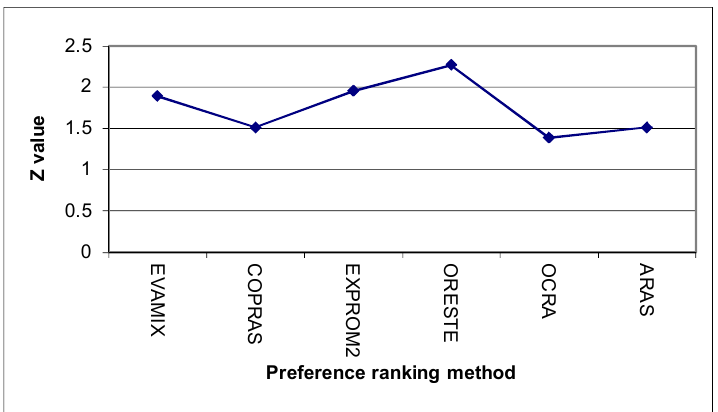
Fig. 1. Z values for the six preference ranking methods